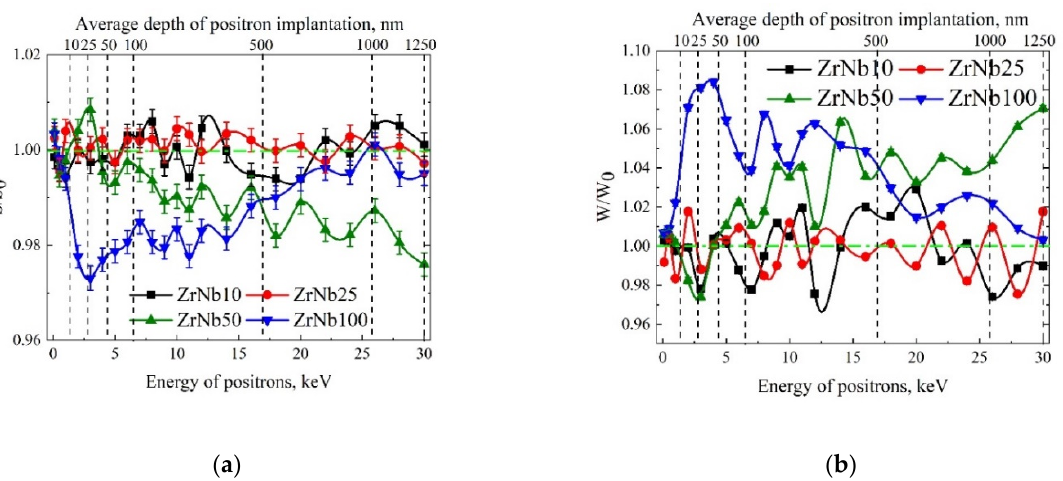
Figure 11. Dependence of the relative S and W parameter on the positron energy S/S 0 = f(E) ( a ) and W/W 0 = f(E) ( b ) for Zr/Nb NMCs after irradiation.